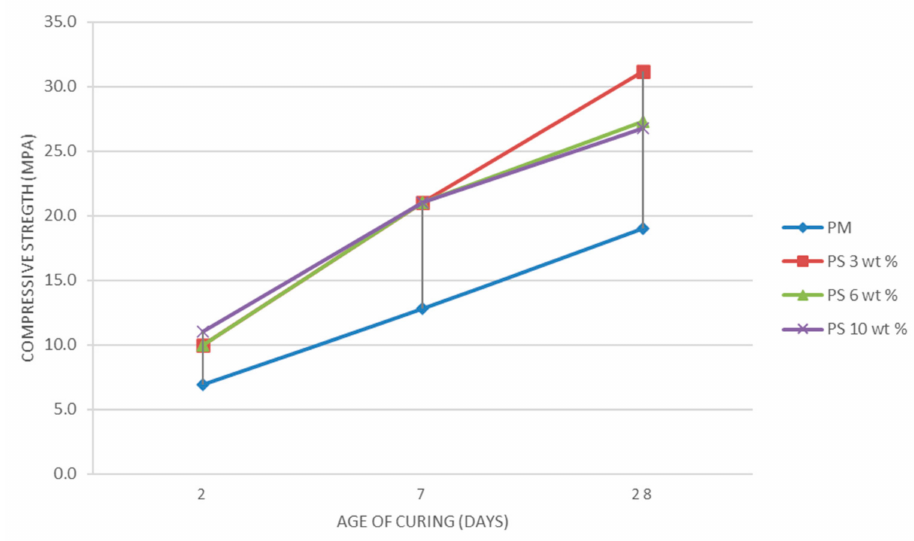
Figure 6. The diagrams of compression strength results for samples with hydrogen plasma vitrified fiberglass (PS 3 wt %, PS 6 wt %, and PS 10 wt %) and the control sample